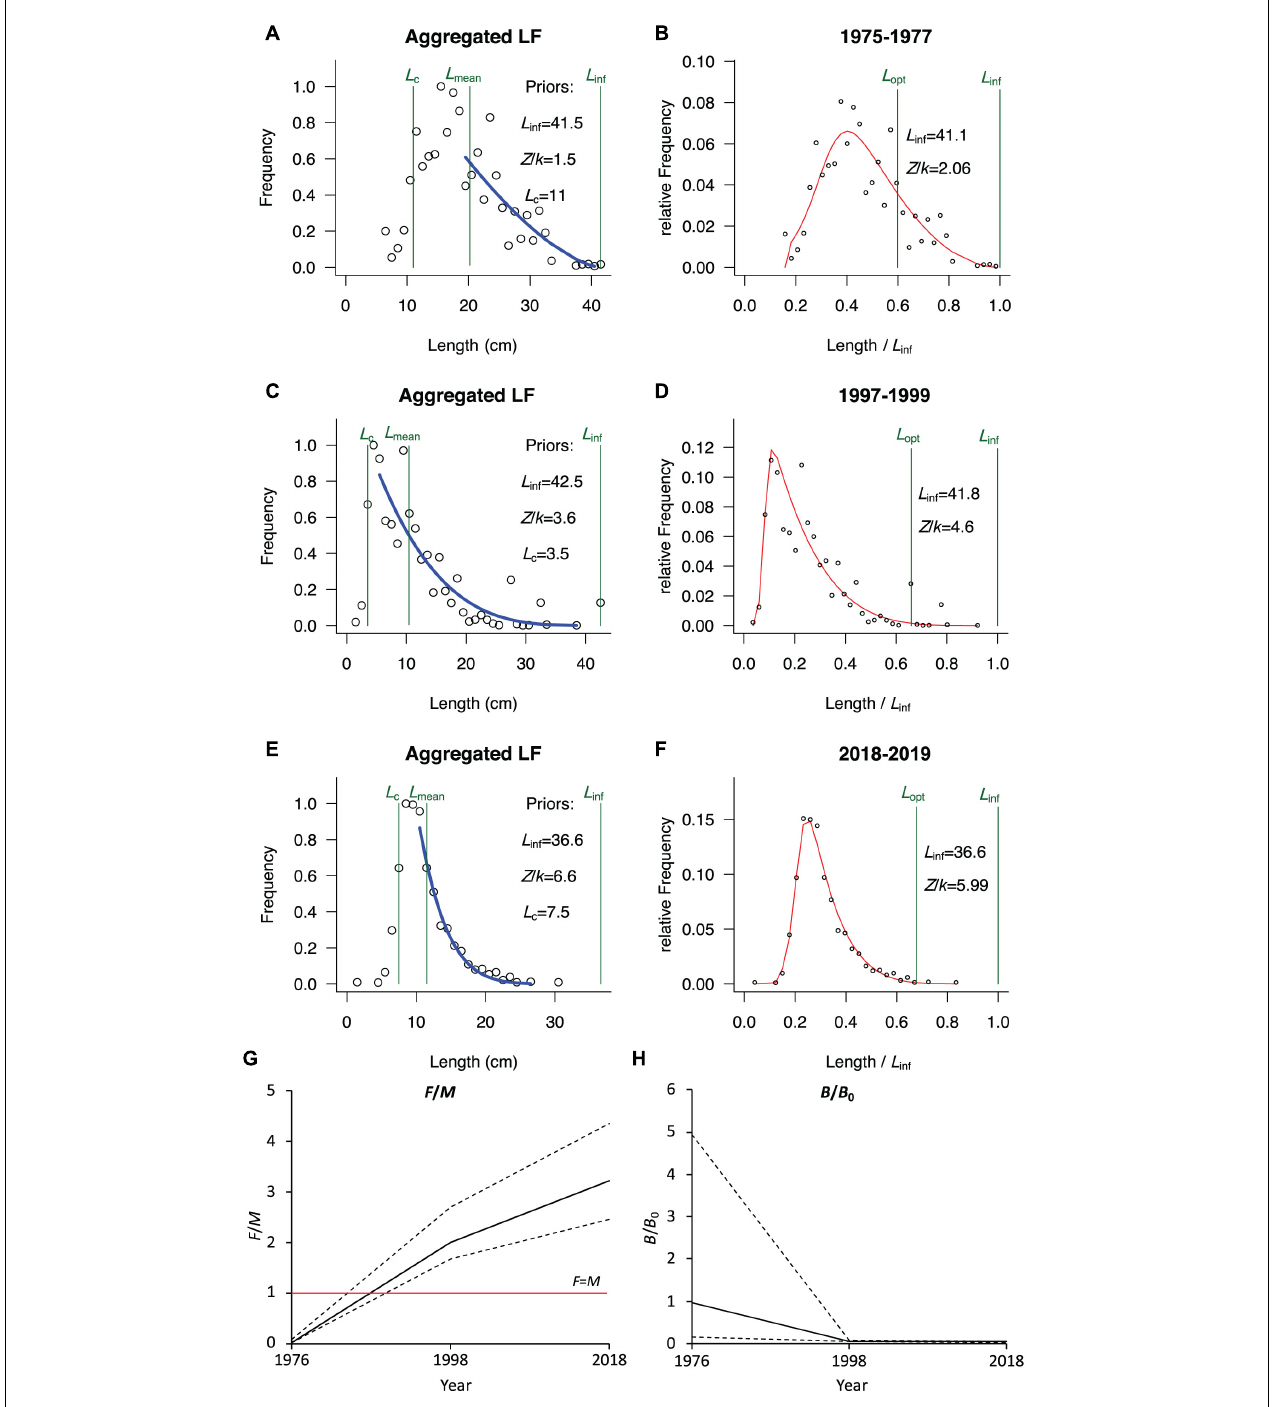
FIGURE 2 | Trends of population parameters and relative biomass of the miter squid in the neSCS based on LBB estimation. (A,C,E) The accumulated length frequency data used to estimate priors L inf , L c , L mean , and Z / k , respectively, from 1975 to 1977, 1997 to 1999, and 2018 to 2019. (B,D,F) The relative length frequency data used to fit the red curves which are in turn used to estimate Z / k , M / k , F / k , L c , and L inf . The L opt is calculated based on L inf and M / k . (G) Changes in relative fishing intensity F / M , and (H) changes in relative biomass B / B 0 .